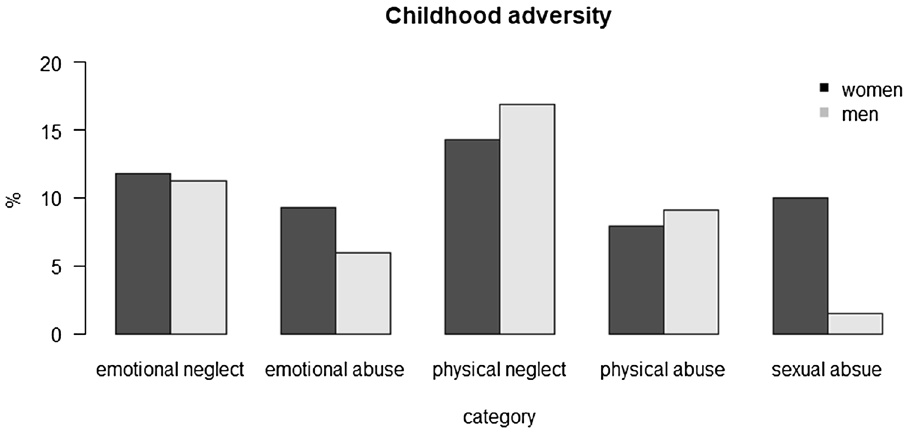
Figure 1. Prevalence of child maltreatment in five categories. Emotional categories as well as sexual abuse were more often reported by women, the physical categories were more often reported by men. Figure was created in R 3.5.2.